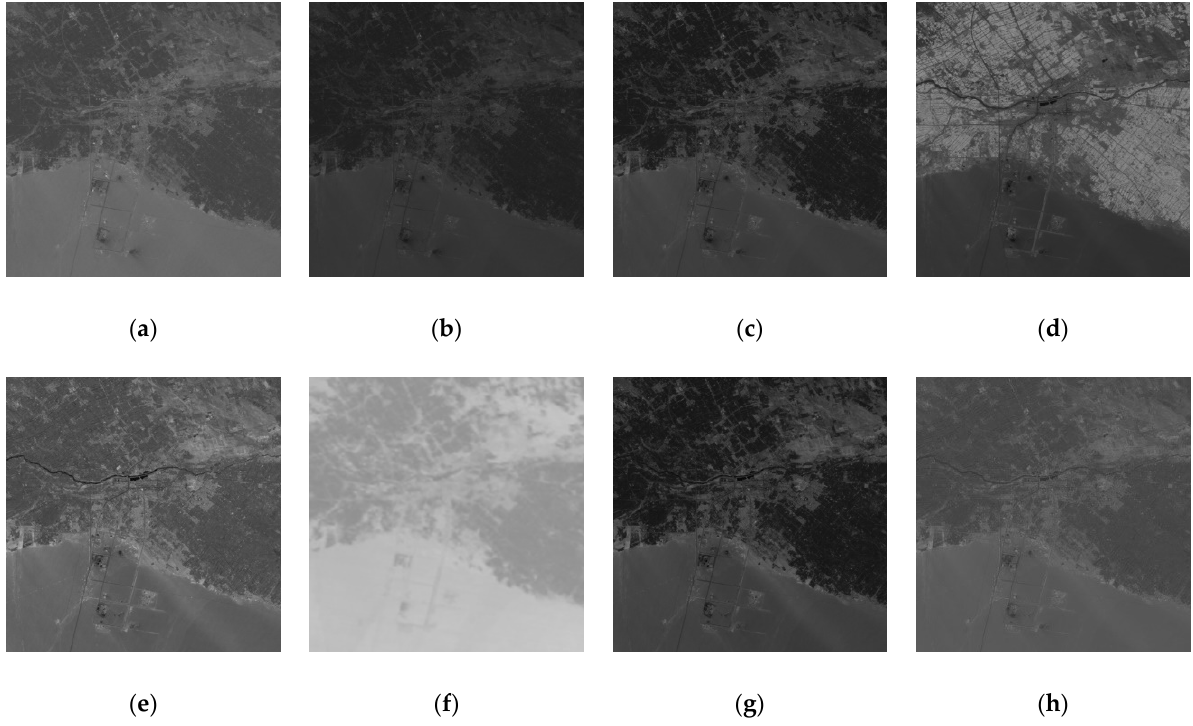
Figure 5. Original multispectral data 3: ( a ) Band 1; ( b ) Band 2; ( c ) Band 3; ( d ) Band 4; ( e ) Band 5; ( f ) Band 6; ( g ) Band 7; ( h ) 7-bands composite image.